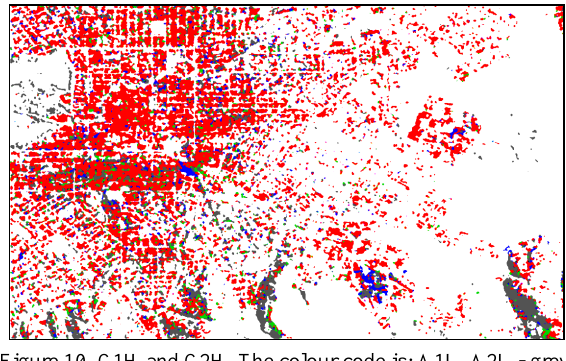
Figure 10. C1H and C2H. The colour code is: A1L, A2L - grey; A1H, A2L - green; A1L, A2H - blue; A1H, A2H - red; background (all other combinations) - white.